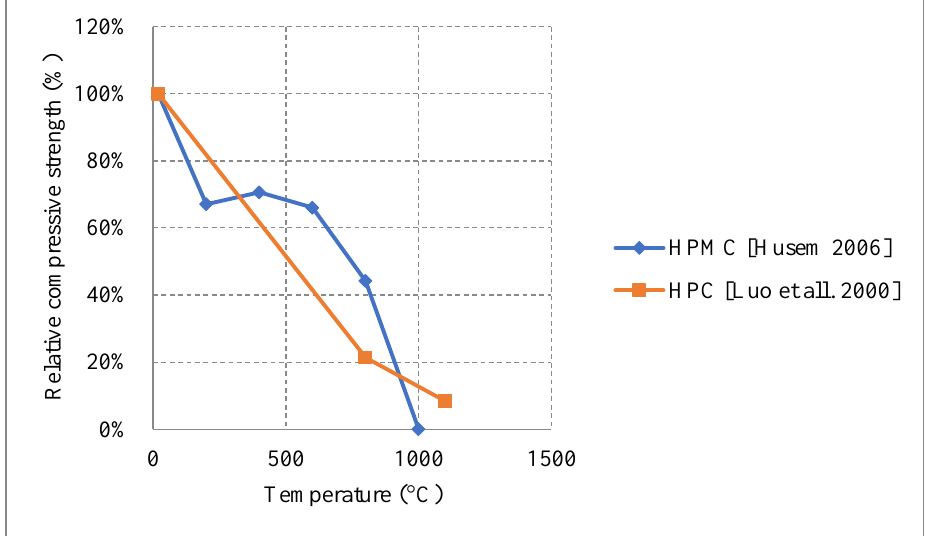
Figure 19. Relative compressive strength of water-cooled HSC. HPMC: High-Performance Micro Concrete [67,79].